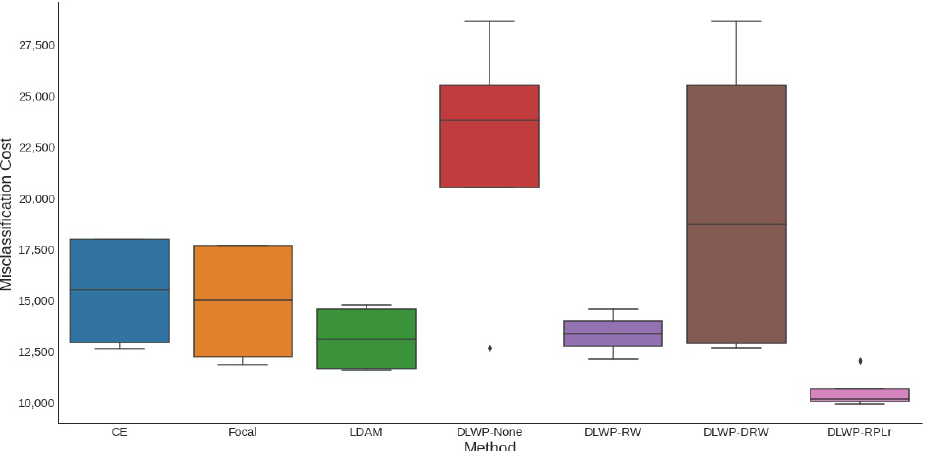
Figure 6. Misclassification costs dispersion for different categories of methods evaluated on the APS Failure at Scania Trucks